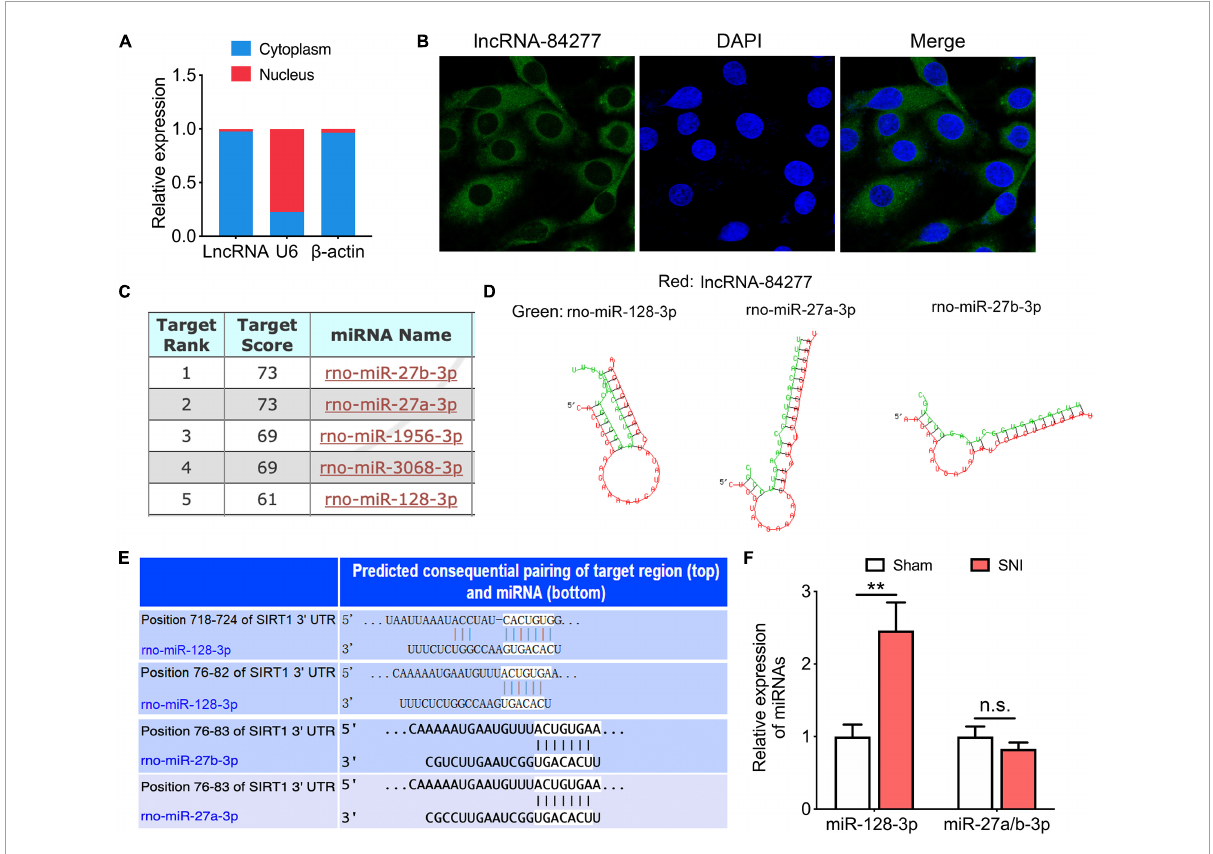
FIGURE4 miR-128-3p is a target of lncRNA-84277. (A) The subcellular position of lncRNA-84277 in the cytoplasm or nucleus. β -actin and U6 were used as the cytoplasmic and nuclear control, respectively ( n = 3). (B) RNA fluorescence in situ hybridization (FISH) for lncRNA-84277 (magnification × 1200). The lncRNA-84277 FISH probe was green and the DAPI nuclear dye was blue. (C) The top five miRNAs interacted with lncRNA-84277 predicted by miRDB (http://mirdb.org/). (D) The binding sites of the three miRNAs (miR-128-3p, miR-27a-3p, miR-27b-3p) and lncRNA-84277 identified by RNAhybrid (http://bibiserv.cebitec.uni-bielefeld.de/rnahybrid). (E) The binding sites of the three miRNAs (miR-128-3p, miR-27a-3p, miR-27b-3p) interacted with SIRT1 identified by TargetScan (http://www.targetscan.org/vert_72/). (F) The levels of the above three miRNAs in the CeA of rats were determined by RT-qPCR ( n = 8). All data are expressed as the mean ± SEM. ** P < 0.01. n.s., not significant.